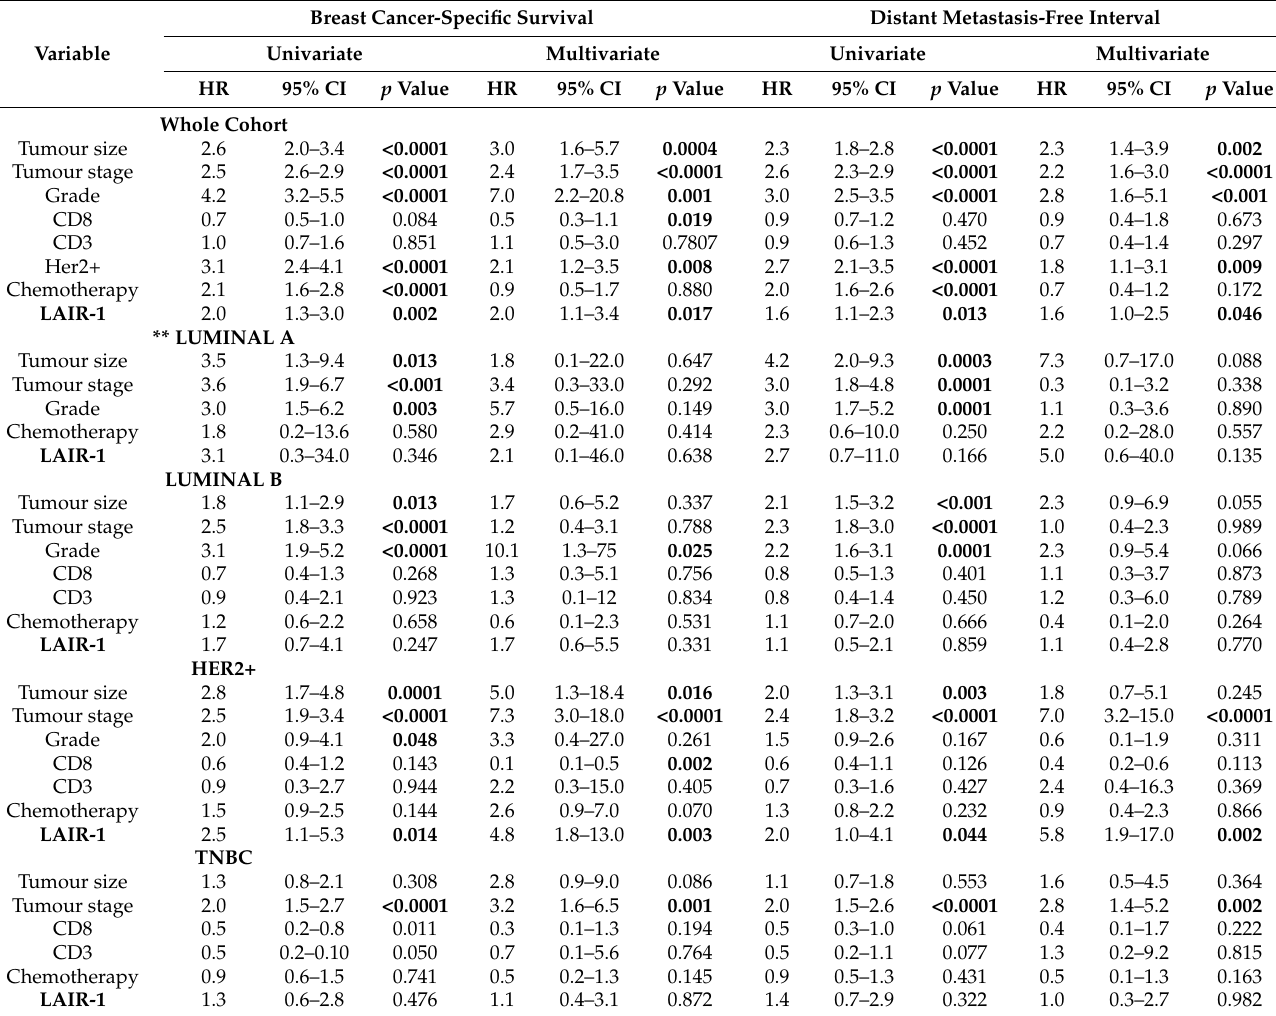
Table 3. Univariate and multivariate analysis of LAIR-1 expression for breast cancer-specific survival and distant metastasis-free survival.